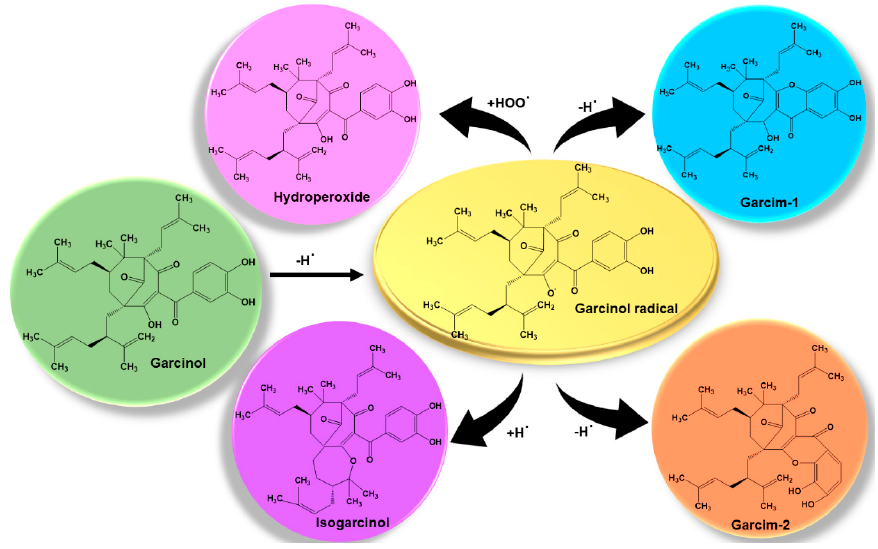
Figure 4. Schematic representations of garcinol and its derivatives in response to free radicals.